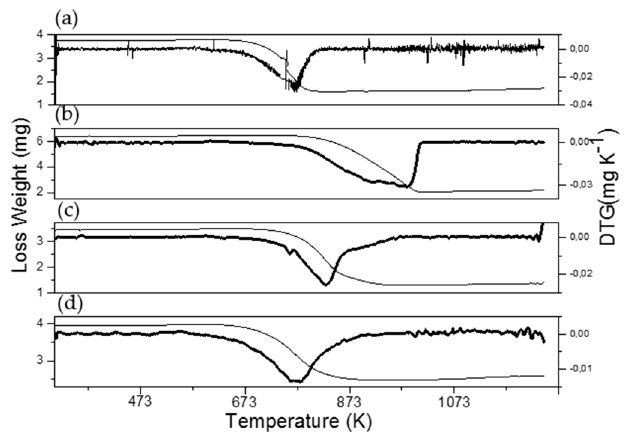
Figure 14. TGA-DTG of supported Ni 1-x Co x / La 0.8 Ce 0.2 catalysts after the ethanol decomposition reaction: (a) Co, (b) Ni 0.1 Co 0.9 , (c) Ni 0.4 Co 0.6 , and (d) Ni 0.7 Co 0.3.